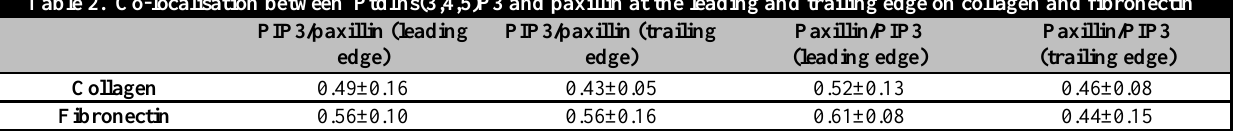
Table 2. Co-localisation between PtdIns(3,4,5)P3 and paxillin at the leading and trailing edge on collagen and fibronectin PIP3/paxillin (leading Collagen Values are expressed as